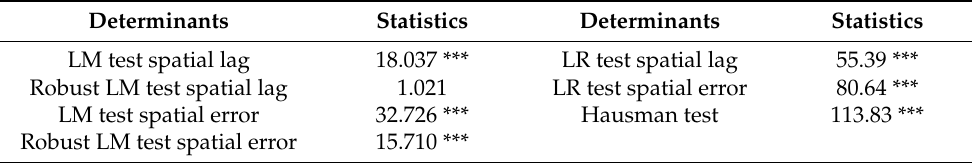
Table 5. Diagnostic test results.